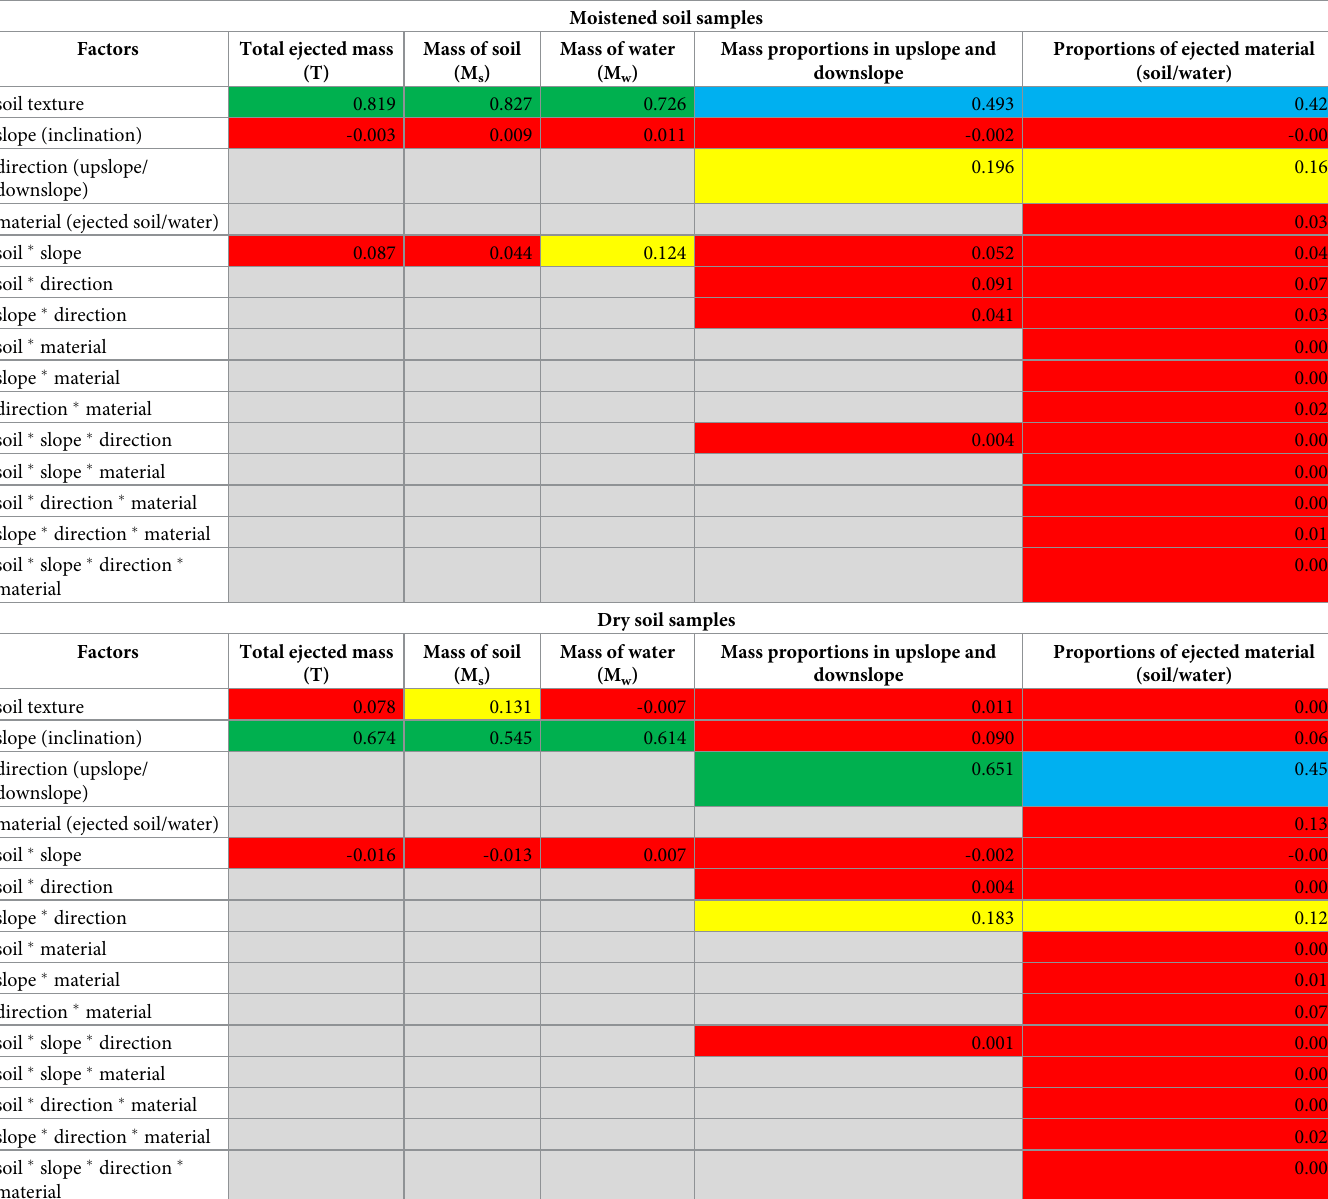
Table 3. Values of ω 2 indicating to what extent individual factors or groups of factors influenced the results of the investigated quantities.